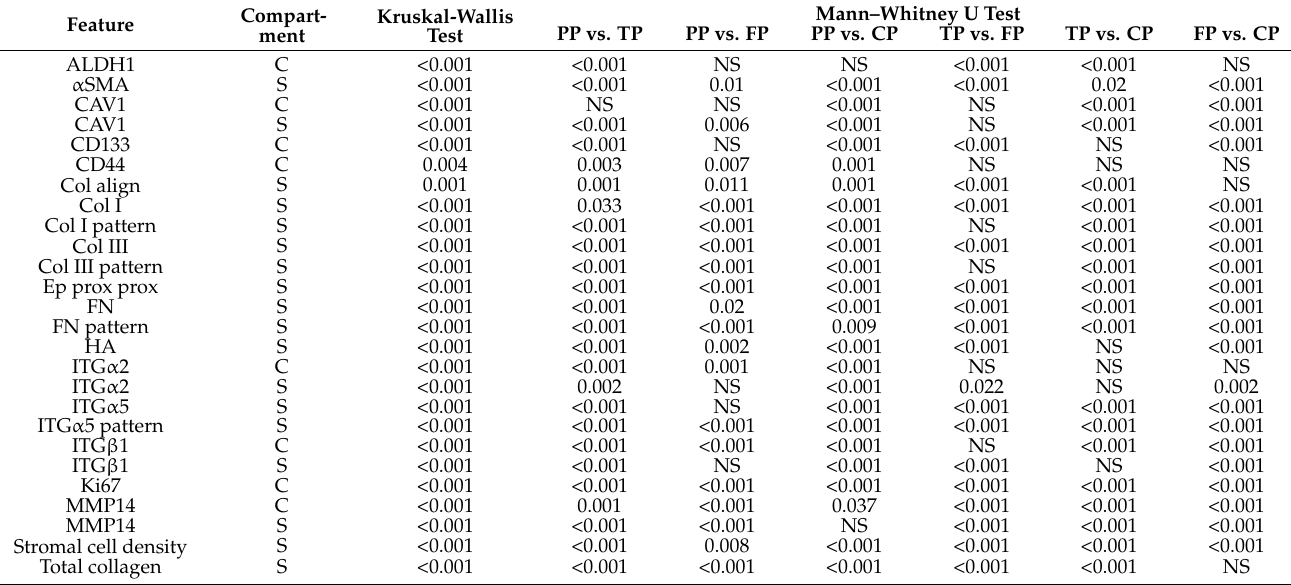
Table 2. Statistical results for the panel of features compared between the tumor patterns. Low p -values (<0.05) indicate significant differences between the feature data corresponding to the different morphological